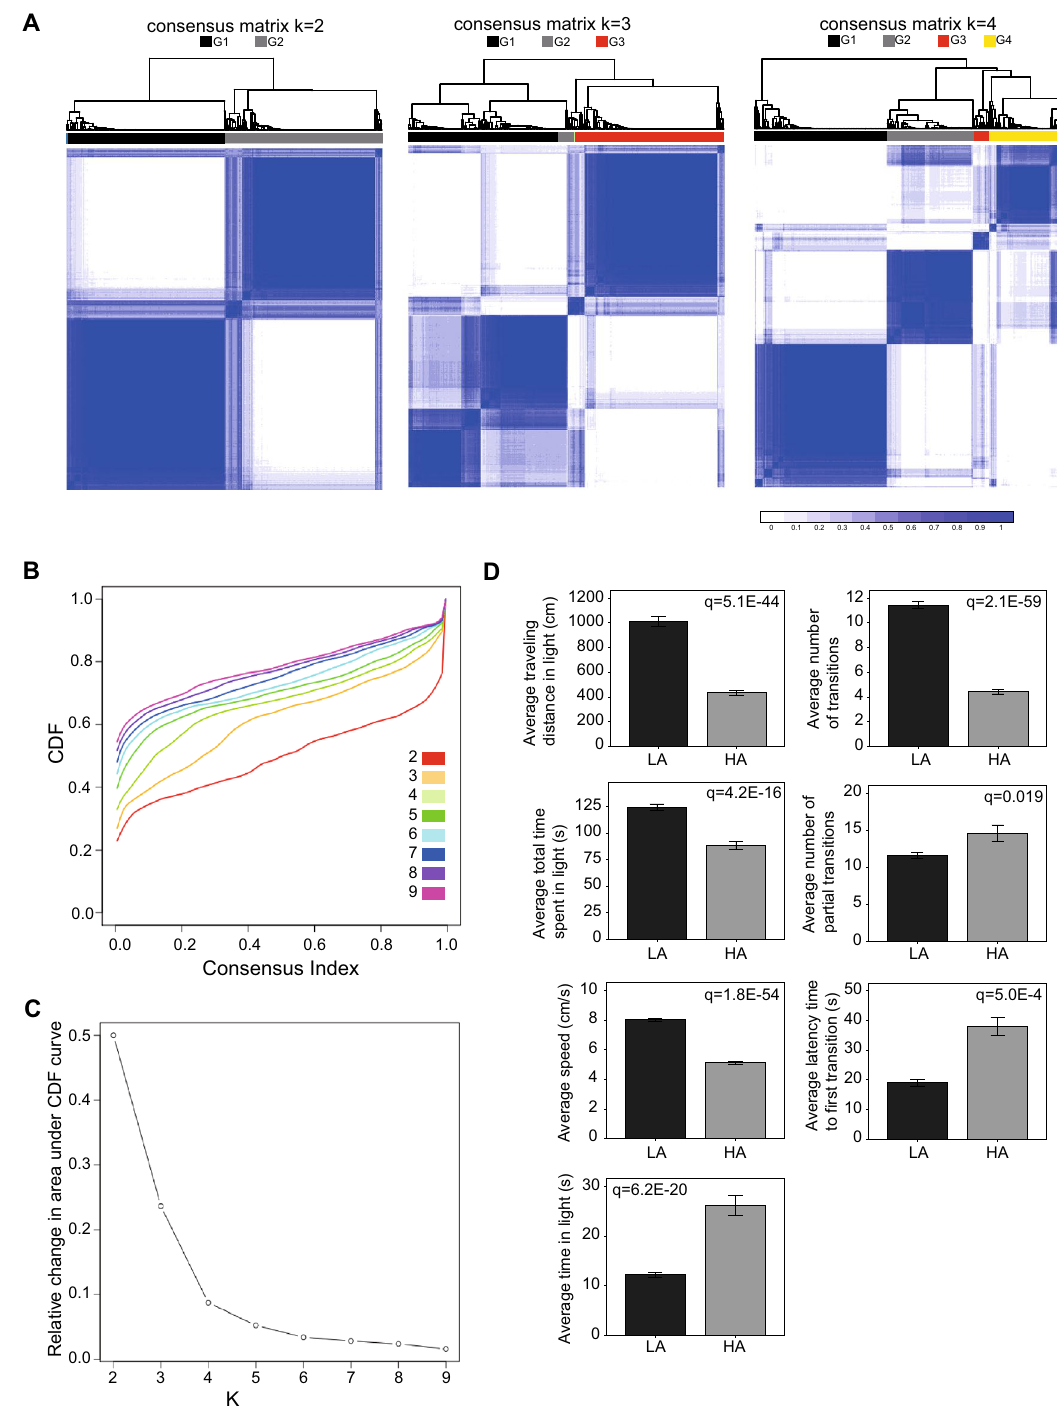
Figure 2. Classification of CC mice into low and high anxiety based on seven anxiety-related phenotypes. ( A ) Consensus classification heatmaps based on two, three or four clusters. A relative stable partitioning of the samples is seen at K=2. The blue color in the clustering diagram refers to the consistency by which each sample is assigned to a specific cluster (dark blue indicates 100% confidence in the assigned class). ( B ) Cumulative Distribution Function (CDF) plot of consensus membership values for solutions with two to nine clusters. ( C ) Delta area curve of consensus clustering for solutions with two to nine clusters. ( D ) Difference in seven anxiety-related phenotypes between mice assigned to the low anxiety (LA) group and mice assigned to the high anxiety (HA) group. P-values were obtained by Mann-Whitney test and corrected for multiple comparisons by